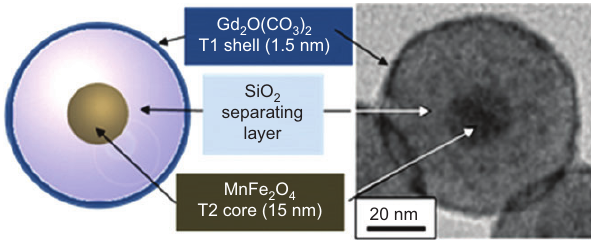
Figure 4 Schematic and transmission electron microscope image of core-shell type DMCA [MnFe Permission/license was obtained from RightsLink;